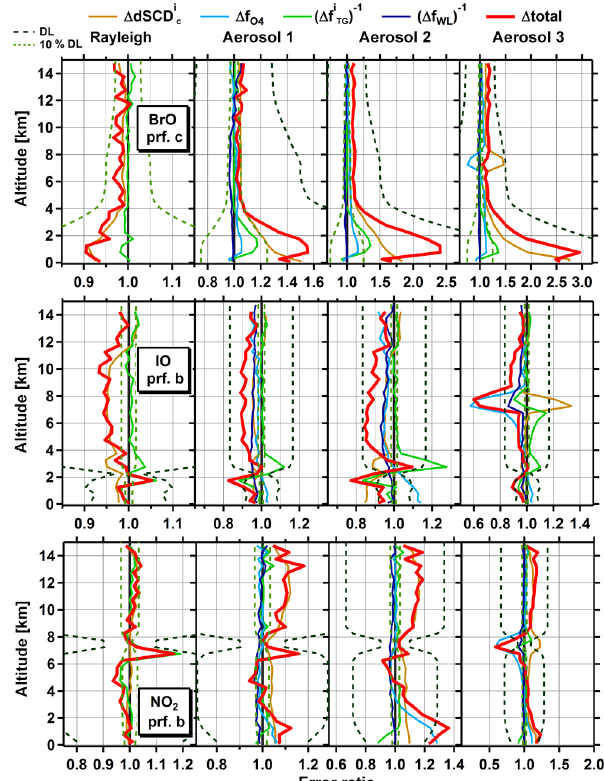
Figure 6. Total error ( (cid:49) total) and error ratios of individual com- ponents of Eq. (1) for BrO c profile (top), IO b profile (middle) and NO 2 b profile (bottom) for Rayleigh and aerosol case studies with SZA = 25 ◦ and (cid:49) SZA = 25 ◦ . Reference altitude is 4.25 for BrO and NO 2 and 14.75km for IO. Green dashed lines show trace gas detection limits. Note the different x axis scaling for individual